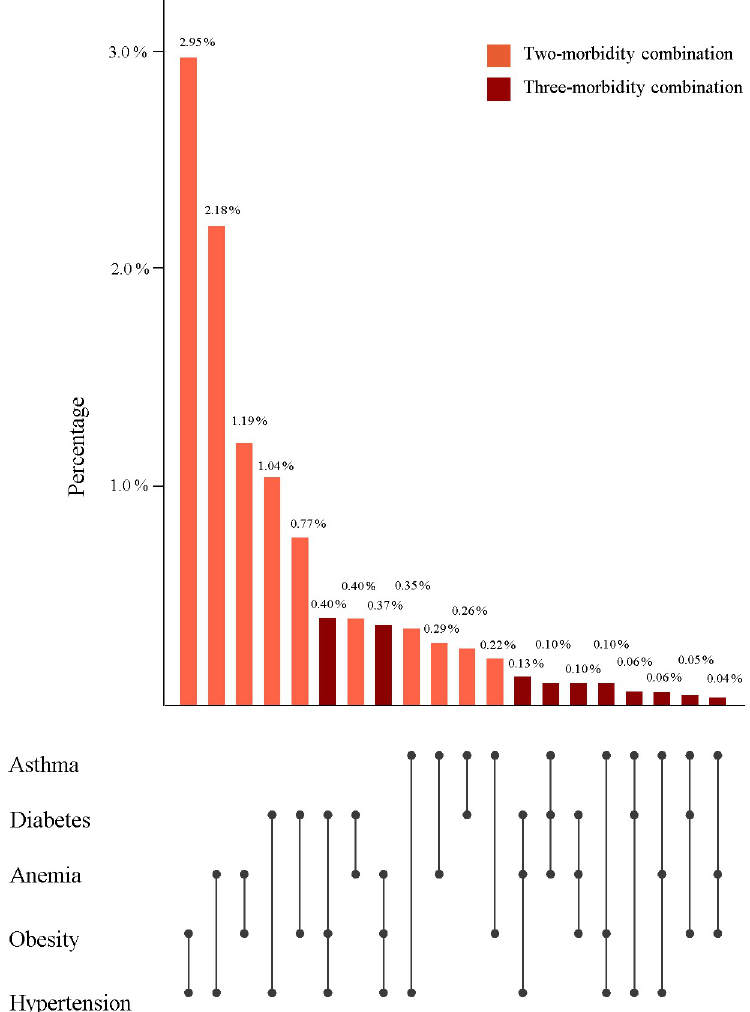
Fig 2. National prevalence of all two- and three-morbidity combinations 1 . 1 95% confidence intervals can be found in S4 Table.